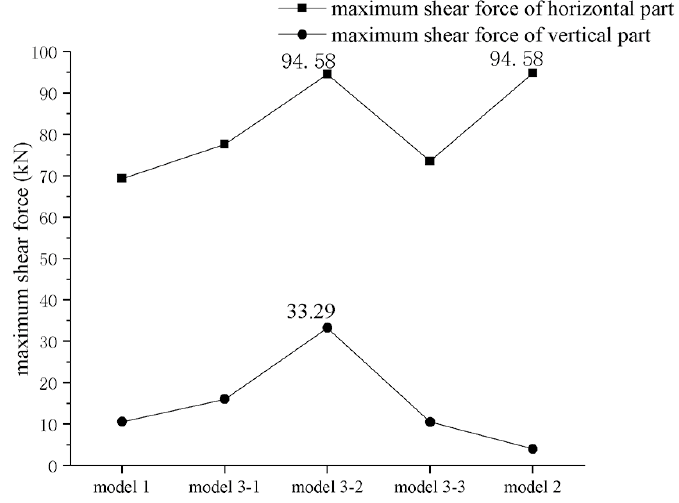
Figure 23. Maximum shear forces of the horizontal part and vertical part for the T-shaped compo- nents in each model.